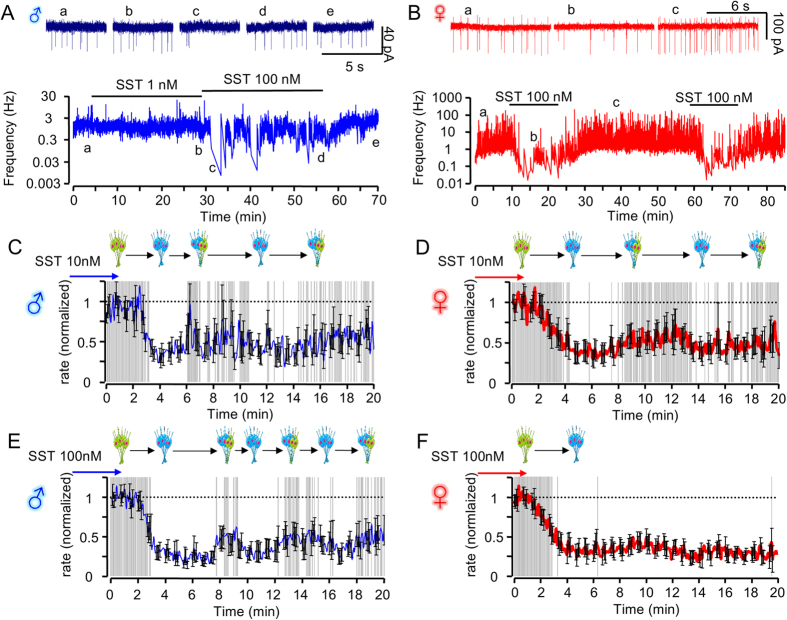
SST induces delayed oscillations in GHRH neuron spike firing.(A) Action potential firing frequency of a GHRH neuron from a male animal during SST superfusion (raw traces, above). (B) As for (A) but female animals. (C) Mean traces showing effects of 10 nM SST (applied t = 0 min) on spontaneous GHRH neuron action potential firing kinetics in male animals (n = 15). Frequencies are normalized (1 = max, 0 = min). Grey (P > 0.01) and white (P < 0.01) shaded areas indicate significant differences in GHRH population electrical activity versus control (hatched line) (paired Student’s t test). The schematic above the traces shows the nature of the pooled population responses (ON, green; OFF, blue; heterogeneous, blue/green). (D) As for (C) but female animals (n = 19). (E) As for (C) but responses to 100 nM SST (n = 14). (F) As for (E) but female animals (n = 13). The control action potential frequencies were 1.92 ± 0.5 Hz in (C); 1.61 ± 0.5 Hz in (D); 2.61 ± 0.6 Hz in (E); and 2.24 ± 0.4 Hz in (F).